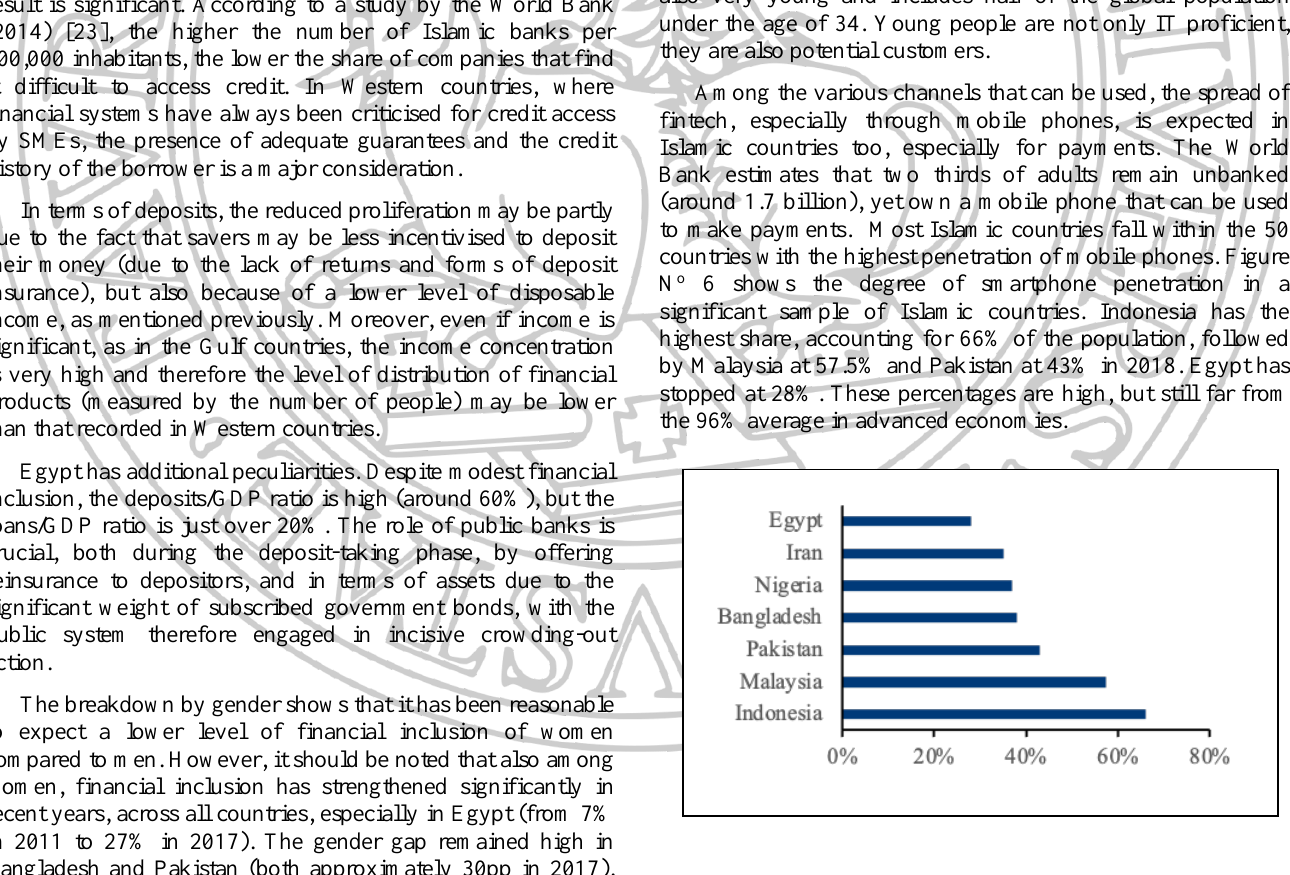
Figure 4. Adults with a bank current account (in some Islamic countries, % of adults, over 15 years of age). Notes: LMI=Lower middle income, UMI=Upper Middle Income, HI=High income. (*) average of the country income category. Source: our calculations based on World Bank and Global Findex database figures. Figure 5. Women with a bank current account (in some Islamic countries, % of adults, over 15 years of age). Notes: LMI=Lower middle income, UMI=Upper Middle Income, HI=High income. (*) average of the country income category. Source: our calculations based on World Bank and Global Findex database figures.